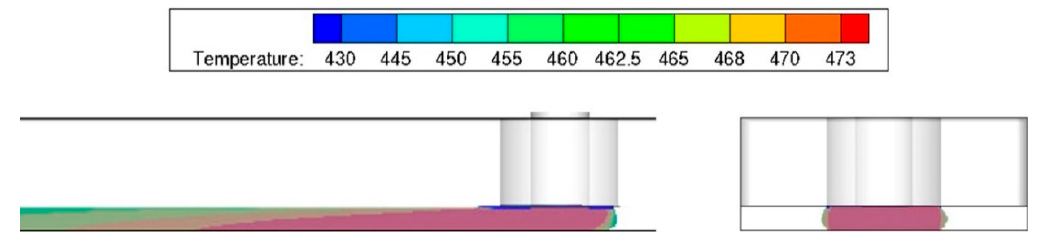
Figure 6. Temperature profile in an extruded strand ( U /< u > = 1, nozzle temperature = 473 K).